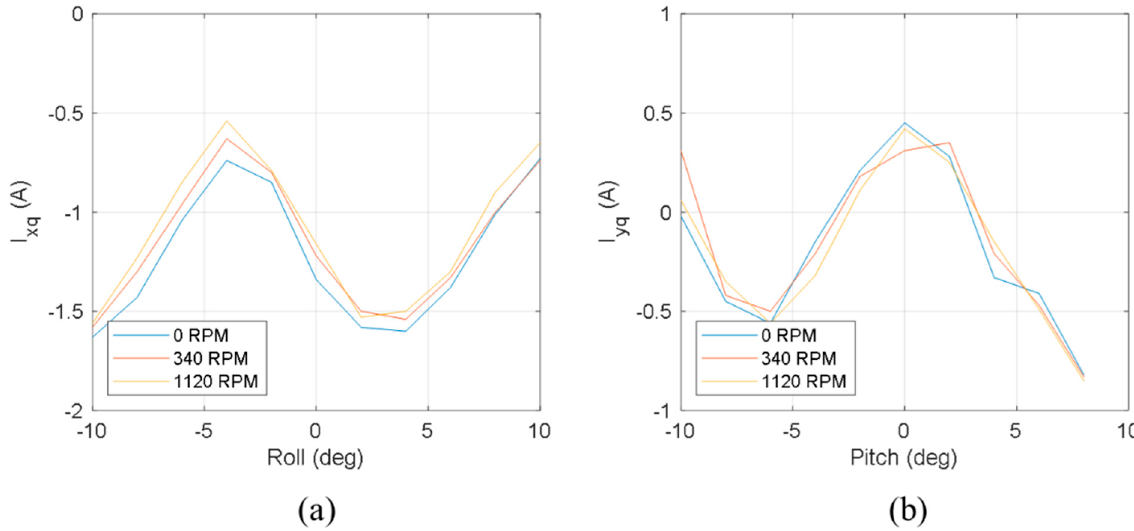
Figure 11. Comparison of q-axis currents at the rotating speed and the tilting angle: ( a ) the control results of the roll motor; ( b ) the control results of the pitch motor.